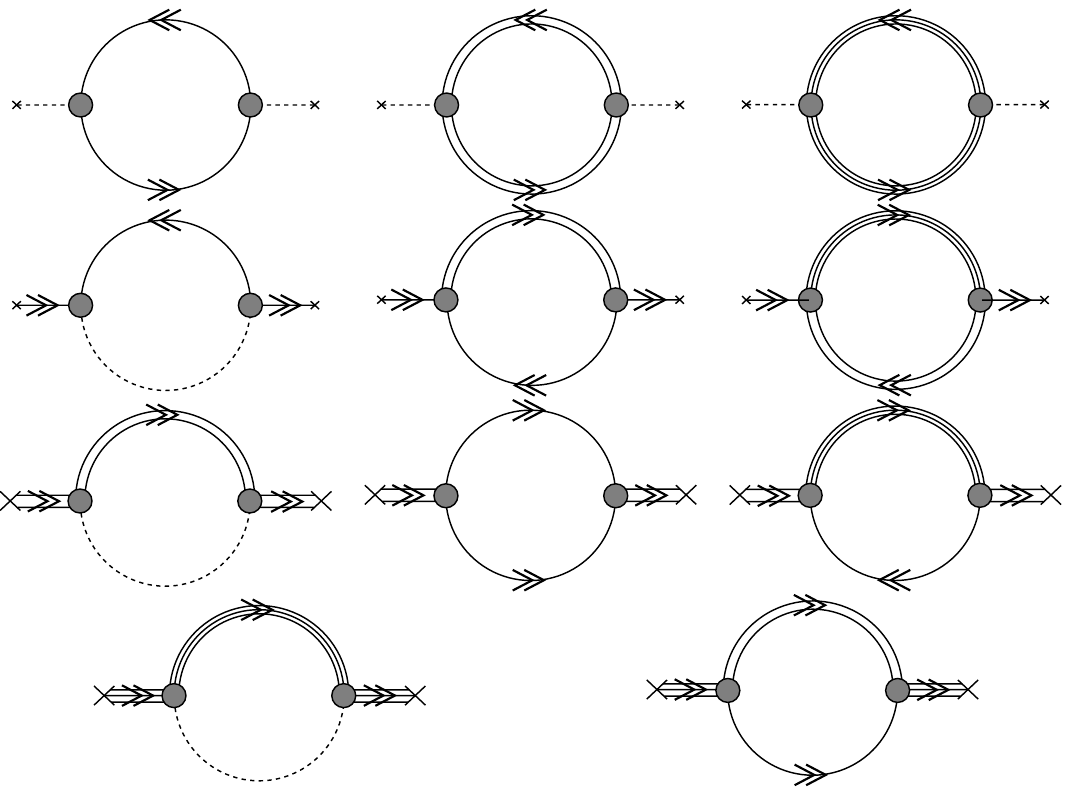
Figure 9. The selfenergy contributions for the Greens functions of the quark-meson-diquark-baryon system, defined by the Φ functional contributions shown in Figure 4. From top to down the four rows of diagrams show the selfenergies for the full propagators of mesons, quarks, diquarks and baryons,